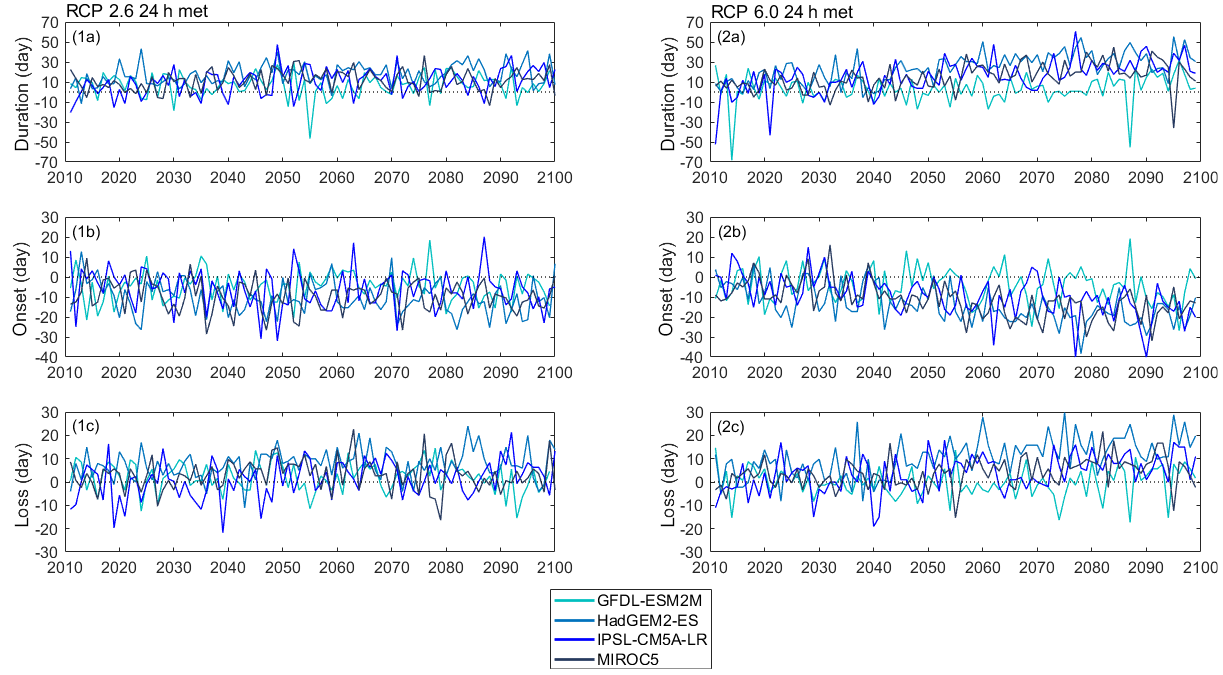
Figure 5. Evolution of annual average projected anomalies (from April to September) for (1a, 2a) duration and (1b, 2b) onset and (1c, 2c) loss of stratification and showing results from when the lake model was forced with daily GFDL–ESM2M, HadGEM2–ES, IPSL–CM5A–LR, and MIROC5 projections from 2011 to 2100 under RCP2.6 and 6.0. Anomalies are relative to the reference period (1981–2010).